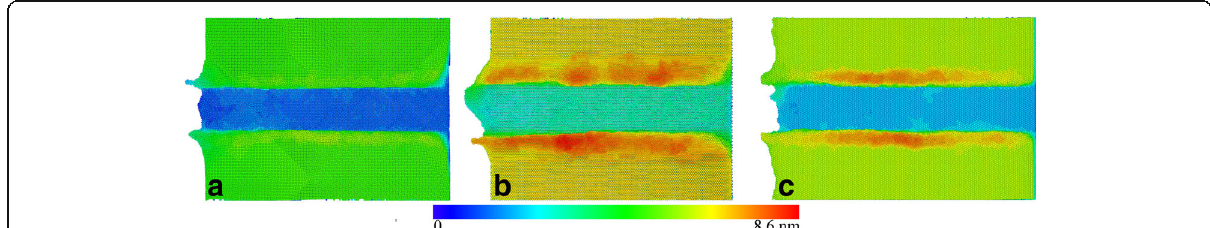
Fig. 10 Crystal orientation dependence of machined surface morphology; (color online) crystal orientation dependence of machined surface morphology. Atoms are colored according to atomic heights. Crystal orientation. a (010). b (110). c